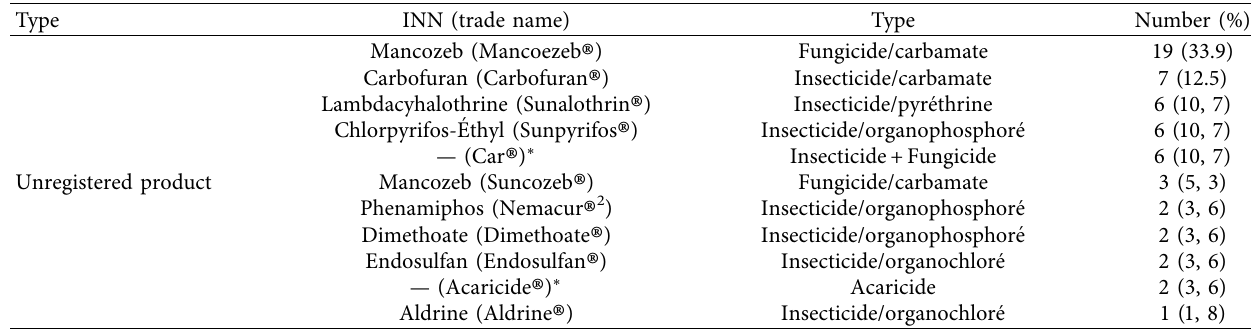
Table 4: List of trade names of pesticides used by growers.